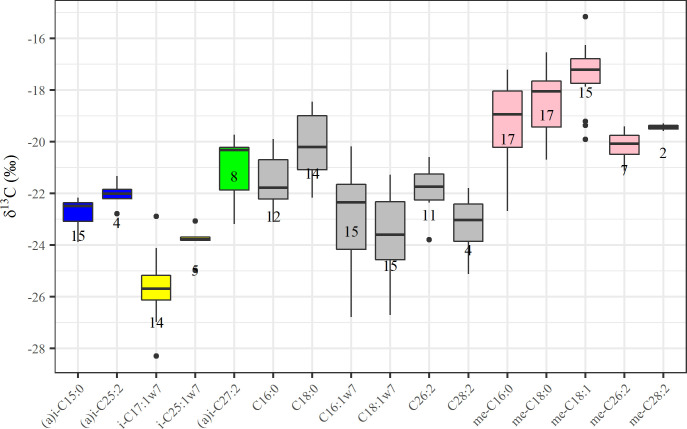
δ13C composition of precursors and dominant LCFAs in analyzed demosponges.Sponge species were pooled together, and the median is indicated in the box plot as black line. The numbers depict the sample size (individual FAME samples). The colors are used to match bacterial precursor FAs with sponge-produced LCFAs. Pink is used for (mid-)Me-branched FAs, grey is used for linear FAs, blue and yellow indicate (a)i-branched FAs with distinct δ13C that may end up in an isomeric mixture, indicated by green (see Fig 5 for biosynthetic pathways).